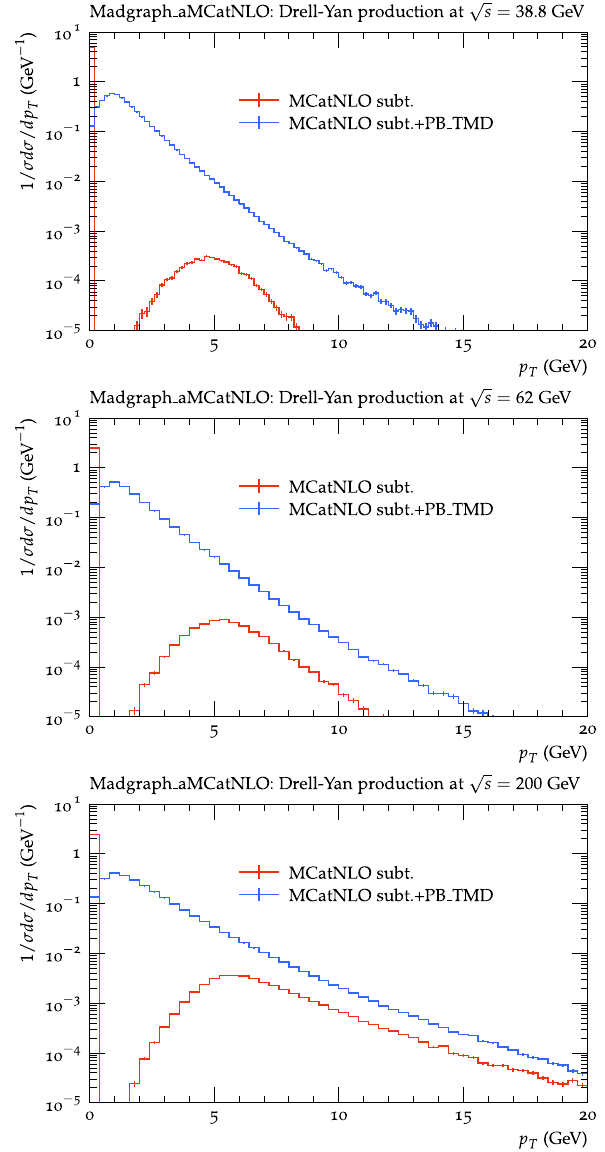
Fig. 3 Transverse momentum spectrum of DY production at parton level(LHElevel)forsubtractiontermsandafterinclusionofPB-TMDs. Distributions are shown for m DY > 4 GeV at √ s = 62 GeV and at s = 200 GeV